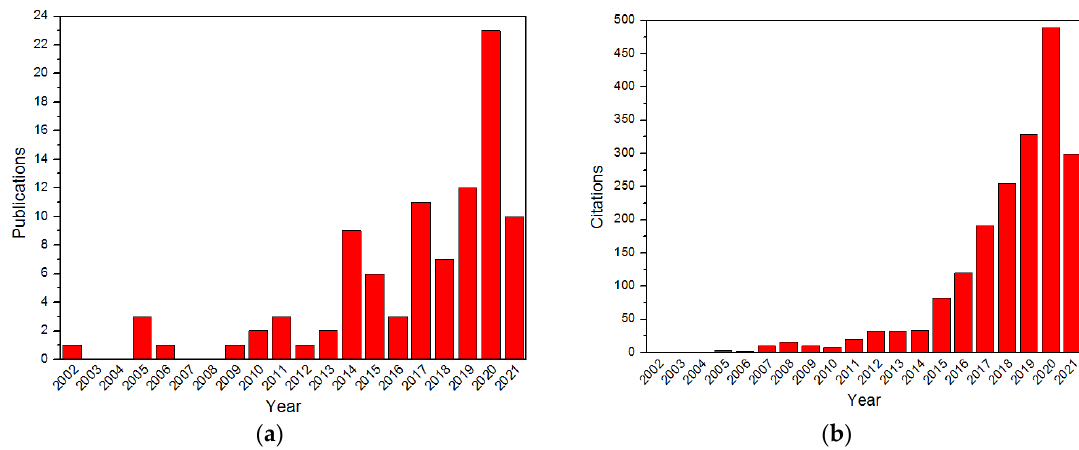
Figure 1. The number of publications ( a ) and citations ( b ) per year on CSEs (source Web of Science, September 2021).